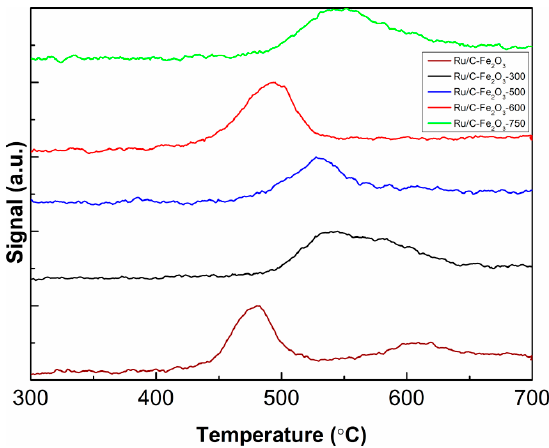
Figure 6. CO-TPD results for Ru/C-Fe 2 O 3 , Ru/C-Fe 2 O 3 -300, Ru/C-Fe 2 O 3 -500, Ru/C-Fe 2 O 3 -600, and Ru/C-Fe 2 O 3 -750.